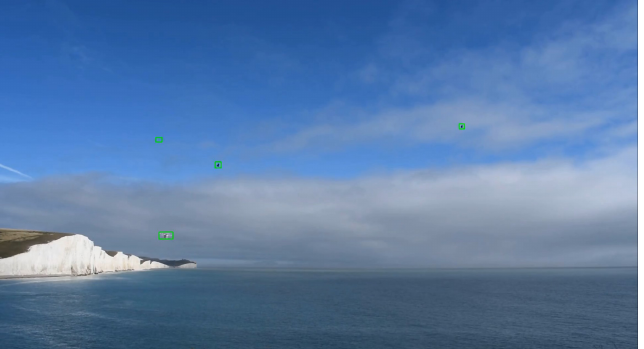
Figure 12. Detection of Multiple Objects.